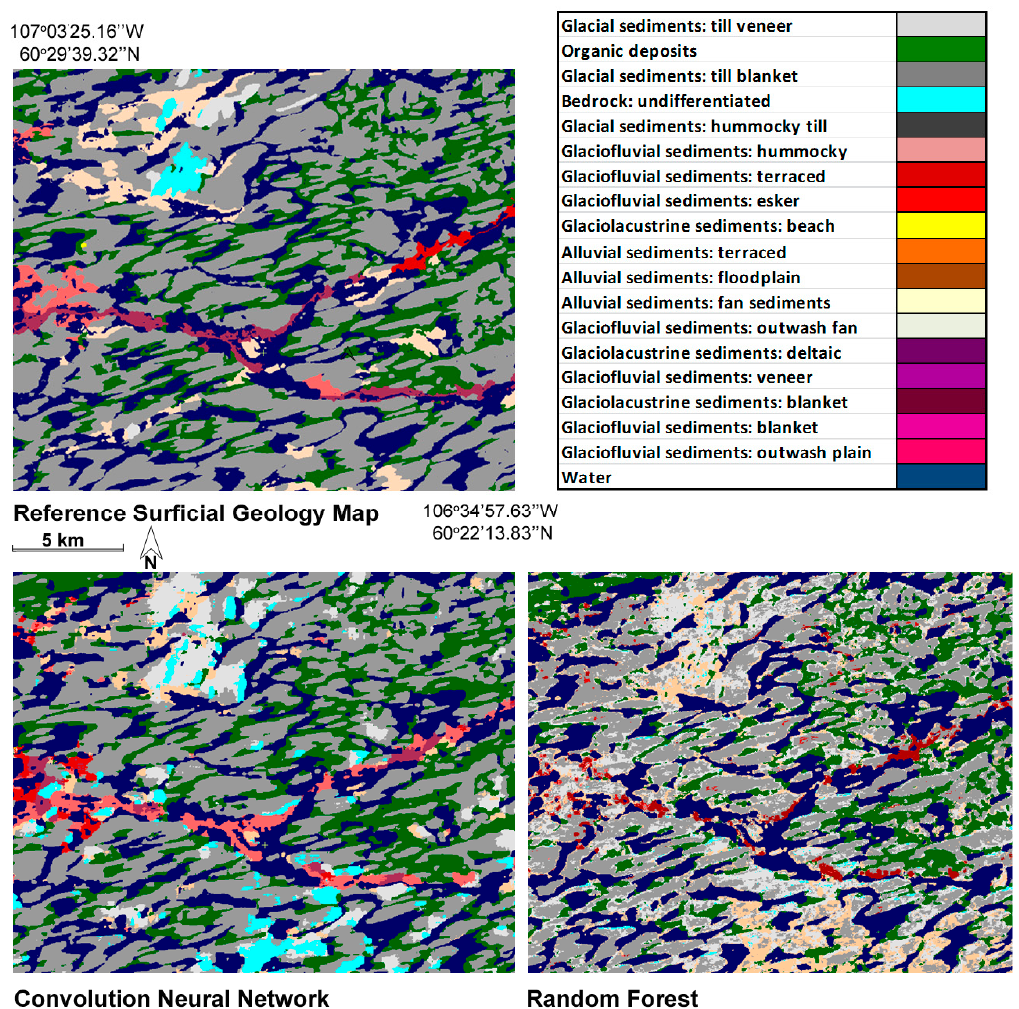
Figure 9. Example area of reference surficial geology map, RF and RESNET result.